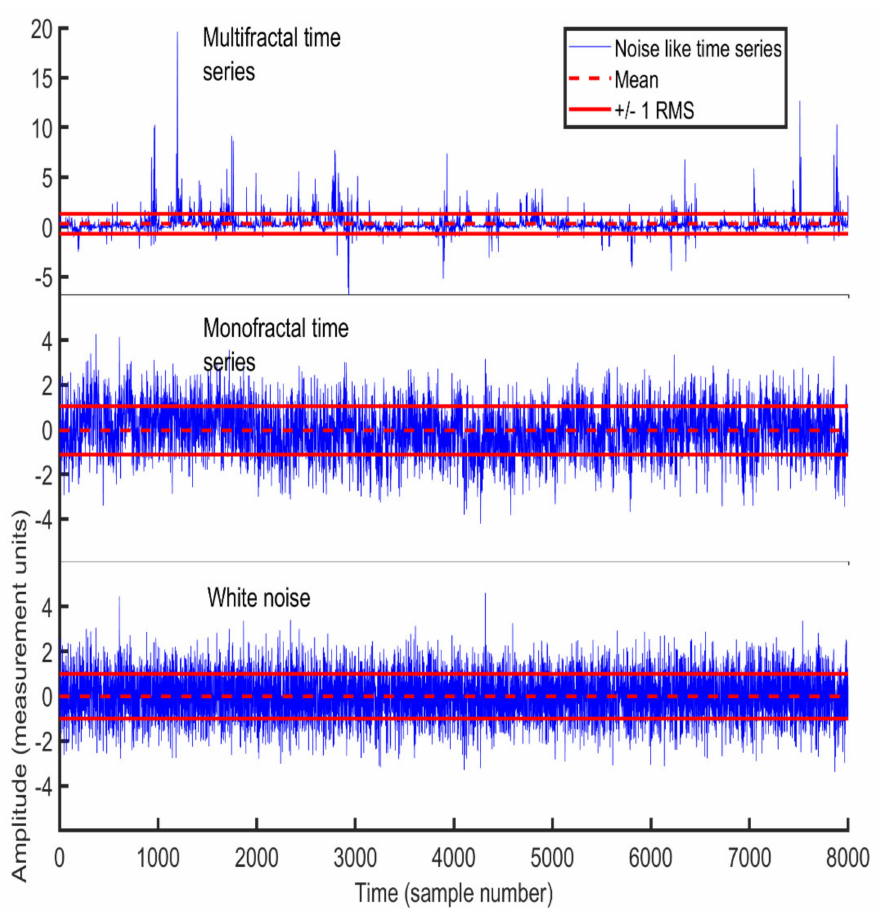
Figure 1. The time series white noise ( lower graph), monofractal ( middle graph), and multifractal ( upper